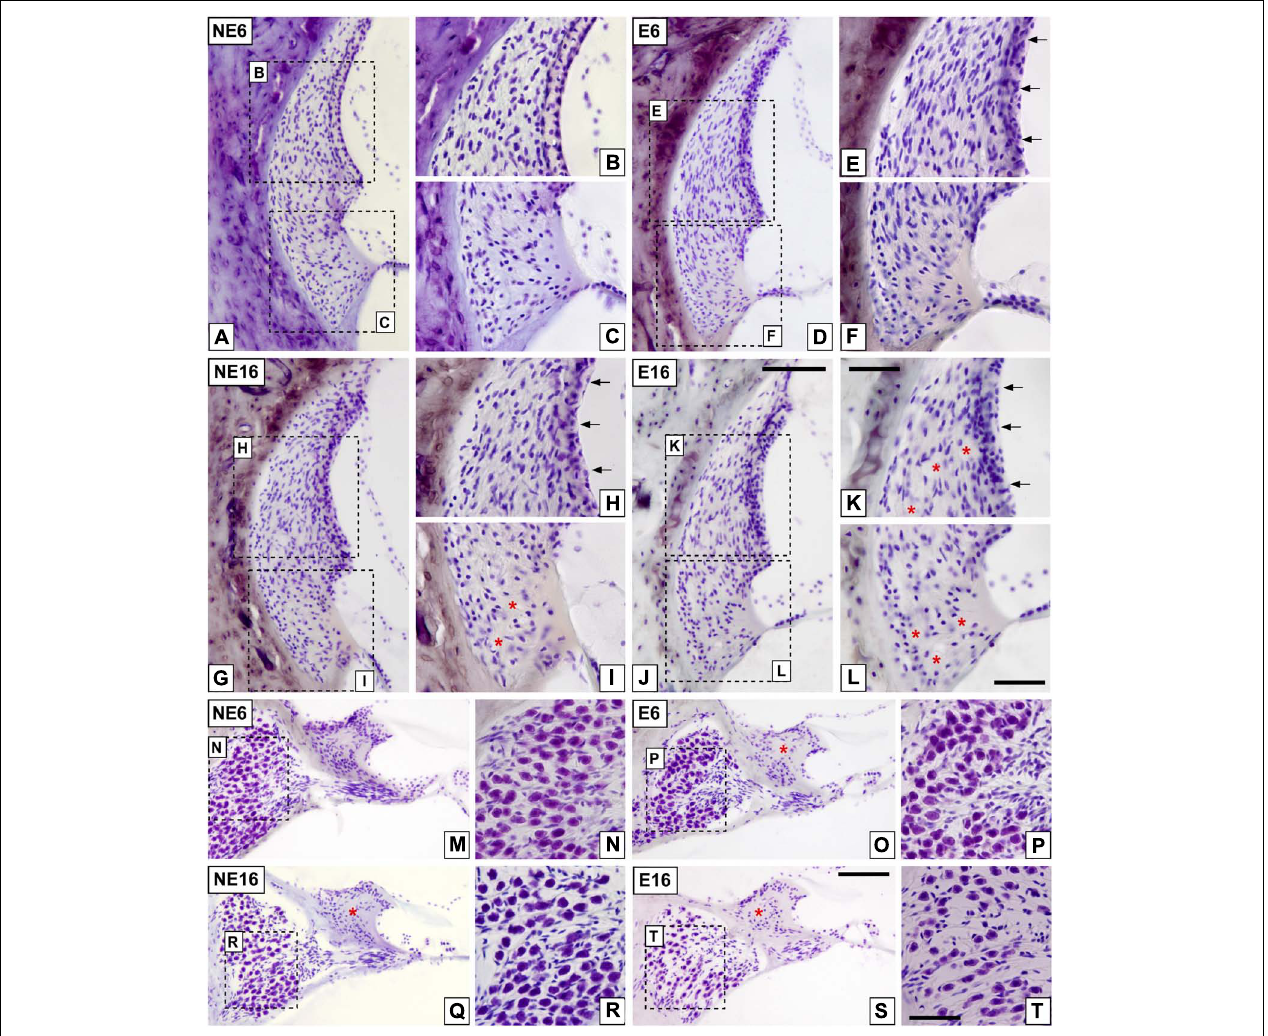
FIGURE 3 | Digital images illustrating cochlear histopathology in NE6, E6, NE16, and E16 rats. (A–L) Cochlear mid-modiolar sections showing the spiral ligament in unexposed (A–C) and noise-exposed (D–F) young rats and unexposed (G–I) and noise-exposed (J–L) aging rats. Notice the abnormal stria morphology in E6, NE16, and E16 rats (arrows in E,H,K ) compared to that in unexposed younger rats (B) . Loss of fibrocytes integrity in NE16 (* in I ) and E16 (* in K,L ) cochleae was also noticeable relative to the NE6 (A–C) and E6 (D–F) groups. (M–T) Cochlear mid-modiolar sections showing the spiral limbus and the spiral ganglion in unexposed (M,N) and NAP-exposed adult (O,P) rats and unexposed (Q,R) and NAP-exposed aging (S,T) rats. Missing spiral limbus cells were detected in the E6, NE16, and E16 groups (* in O,Q,S ) while degeneration of spiral ganglion neurons was seen only in the oldest noise-exposed group (S,T) . Dashed square boxes in low-magnification images in (A,D,G,J) indicate the approximate locations of the higher-magnification images shown for each group. Arrows indicate strial dystrophy and asterisks indicate missing cells in each cochlear structure. Scales bars: 100 µ m in (J,S) ; 50 µ m in (K,L,T) . n = 4 for each animal